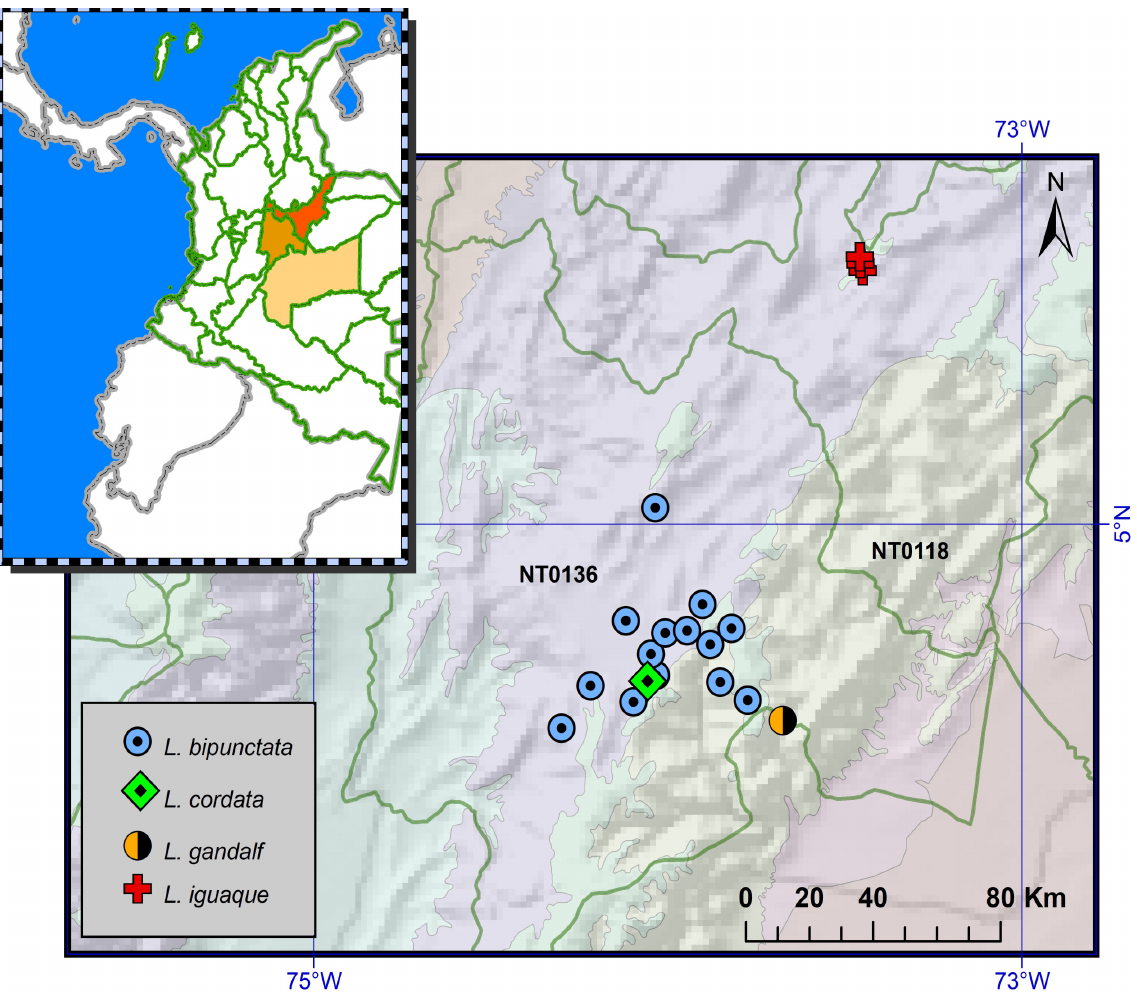
Fig. 14. Central Colombia, showing the distribution of species of Libitia Simon, 1879 (inset: NW South- America, for context). Highlighted Colombian departments are from north to south: Boyacá (red), Cundinamarca (orange) and Meta